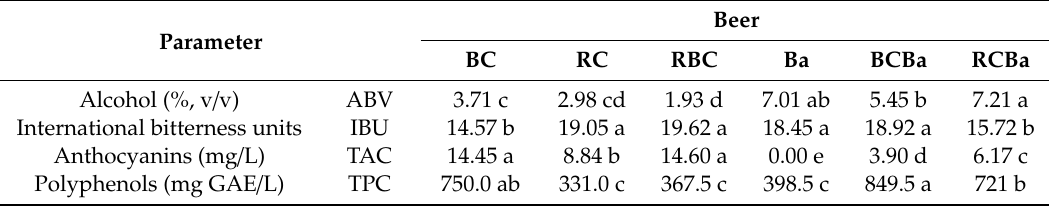
Table 4. Mean score of beer samples for each non-volatile